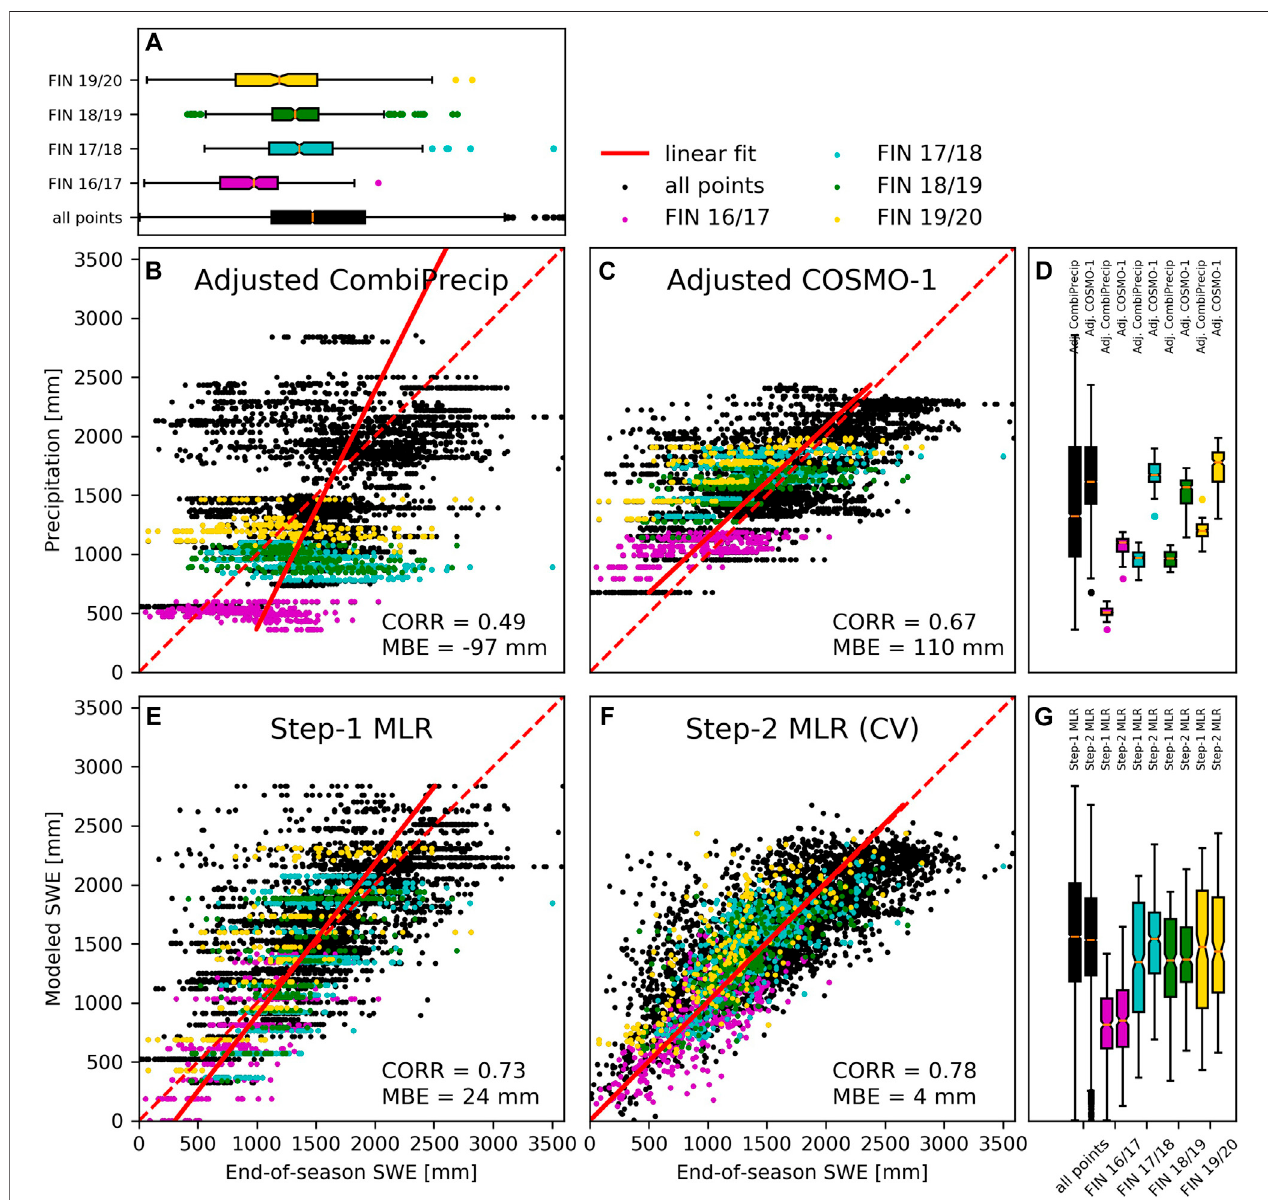
FIGURE 8 | Scatterplots of the in-situ SWE measurements and cumulative precipitation and the total SWEs estimated by the different products and models for all theglaciers.ThecoloreddotsarerelatedtotheFindelglacierestimatesandthedifferentcolorsindicatedifferentwinterseasons (B) :AdjustedCombiPrecip (C) :Adjusted COSMO-1 (E) : Step-1 (F) : Step-2 cross validation. The correlations (CORR) and mean bias errors (MBE) with all in-situ measurements are reported on the graphs. The boxplotsshownin (A) representthedistributionofall in-situ measurements(oftheeightglaciers)andthedistributionofthe in-situ measurementsforindividualyears of the Findel glacier (D) shows the distribution of CombiPrecip and COSMO-1 estimates and (G) shows the distribution of Step-1 and Step-2MLRs estimates.